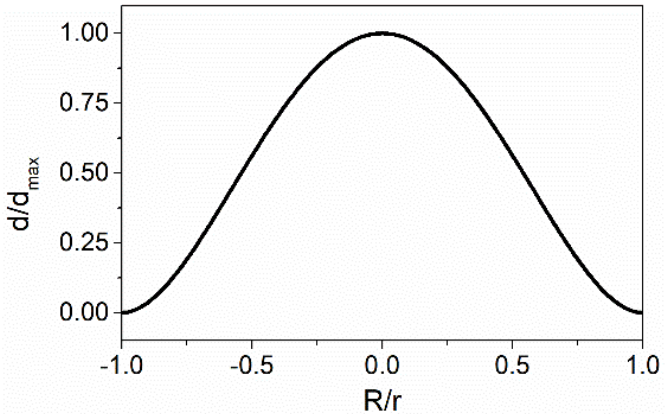
Figure 4. Normalized deformation at any point of the diaphragm, as a function of the normalized distance to the center.